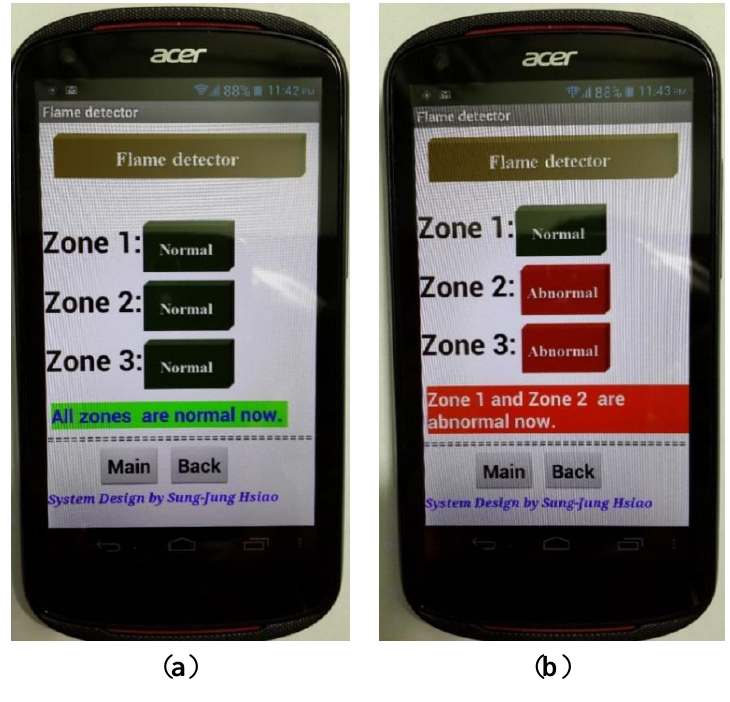
Figure 20. Real-time monitoring each zones situation by these flame sensors. ( a ) Normal situation; ( b ) Abnormal situation.